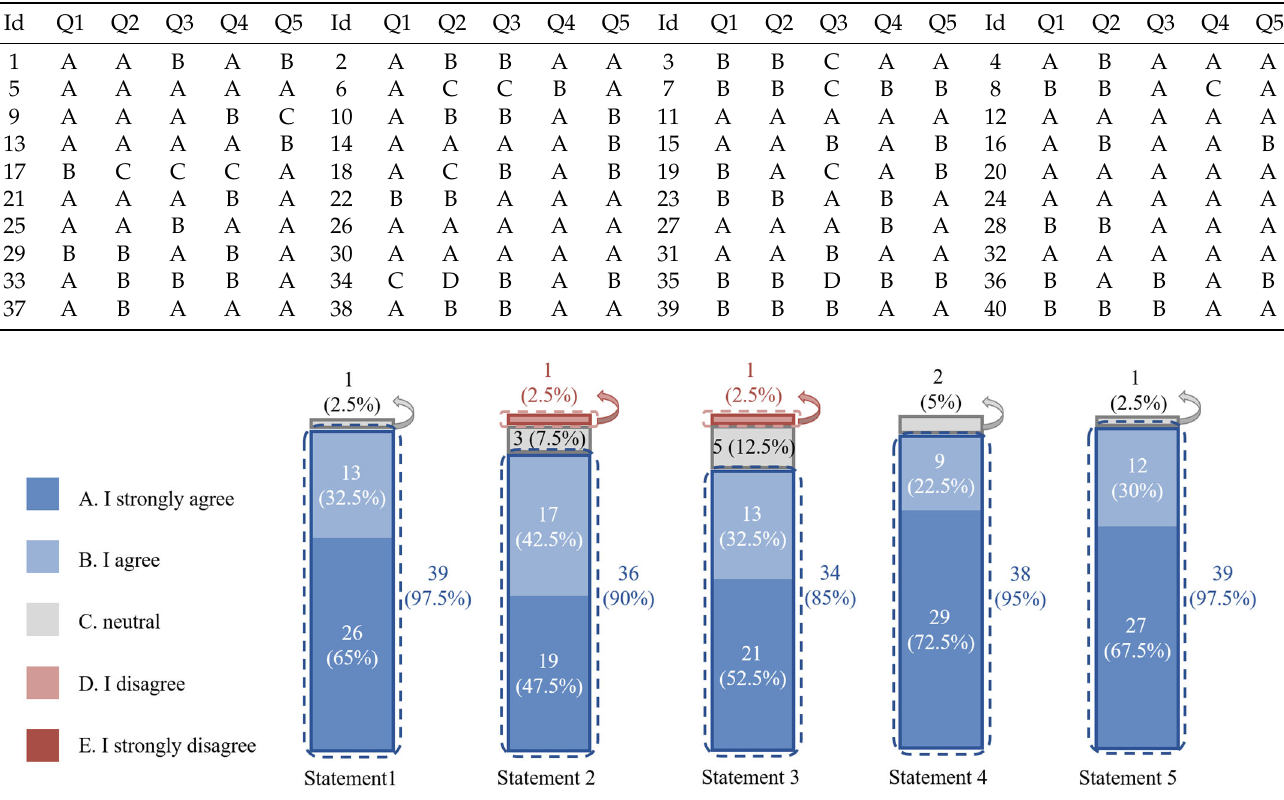
Figure 9. The statistical chart of questionnaire results for map evaluation.